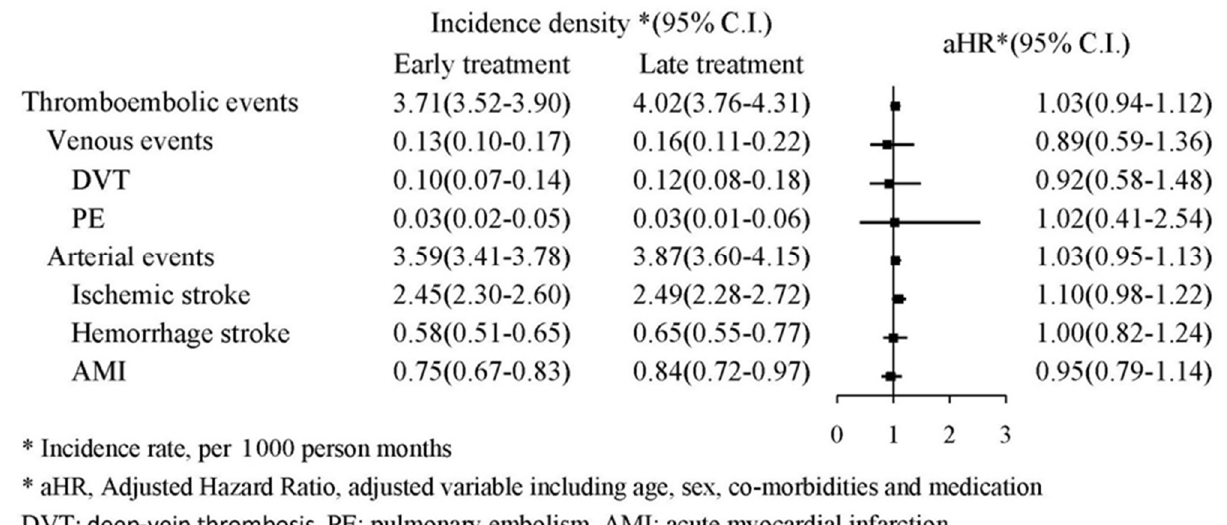
Figure 6. Kaplan–Meier curves for the 52 week thromboembolic events. 4. Discussion In this population-based trial, which included 10,254 patients with gastrointestinal bleeding, early TXA treatment was associated with 36% and 12% lower mortality for a follow-up period of 1 to 8 and 9 to 52 weeks, respectively. Moreover, early TXA treatment